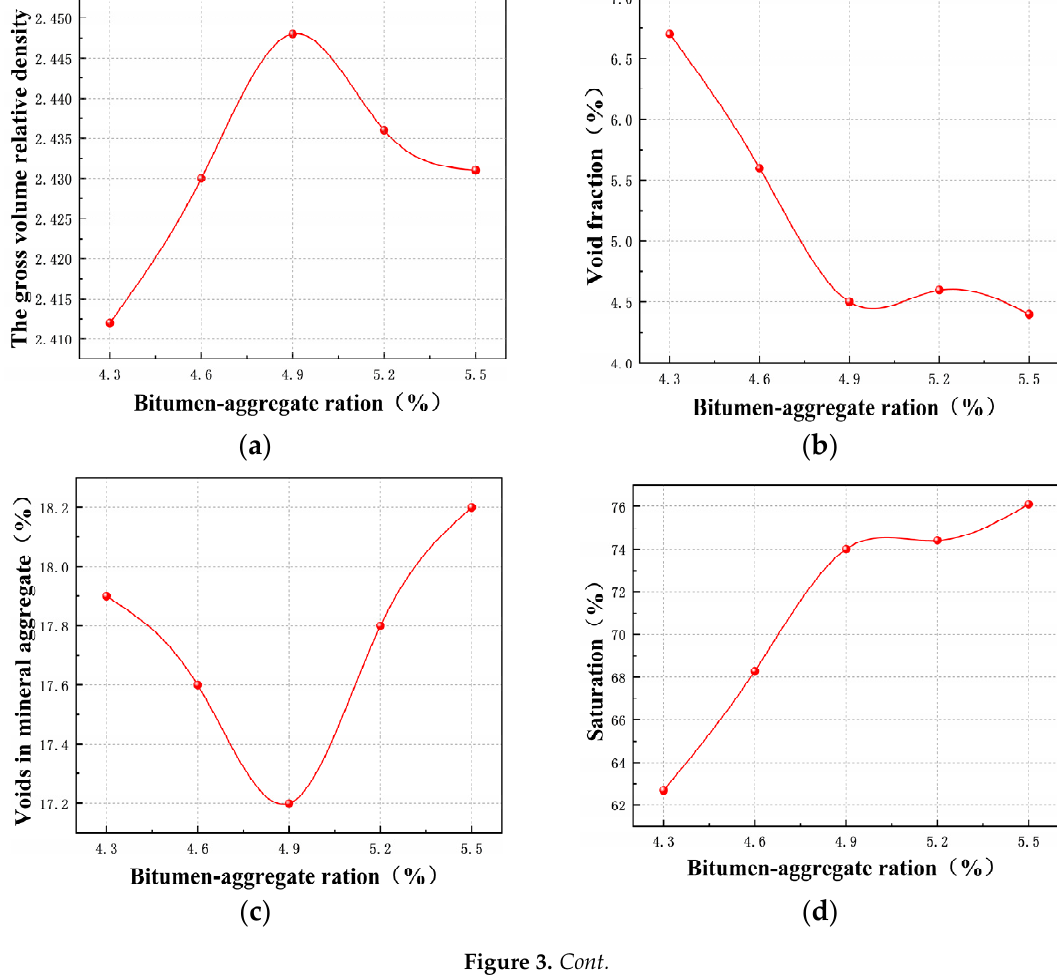
( f ) ( g ) Figure 3. The physical mechanical index of 70# asphalt mixture. ( a ) The gross volume relative den- sity; ( d ) Saturation; ( c ) Voids in mineral aggregate; ( d ) Saturation; ( e ) MS; ( f ) FL; ( g ) The common range. Figure 3 shows that a 1 , a 2 , a 3 , a 4 , OAC min , OAC max are 4.90%, 4.90%, 4.90%, 4.68%, 4.50% and 5.32%, respectively. Therefore, the optimum proportion of the 70# neat bitumi- nous mixtures was 4.9%. The same test method was used to determine the optimum pro- portion of the SBR-modified bituminous mixture and the PS-modified bituminous mix- tures, which were 5.0% and 5.1%, respectively. 2.3. Properties Evaluation 2.3.1. Physical Property Test The physical properties of PS-modified bitumen were characterised by penetration at 25 °C, softening point, ductility at 5 °C, and Brockfield viscosity test at 135 °C. These tests were conducted according to the T0604, T0606, T0605, and T0625 of Standard Test Methods of Bitumen and Bituminous Mixtures for Highway Engineering (JTG E20-2011) [26] specification.